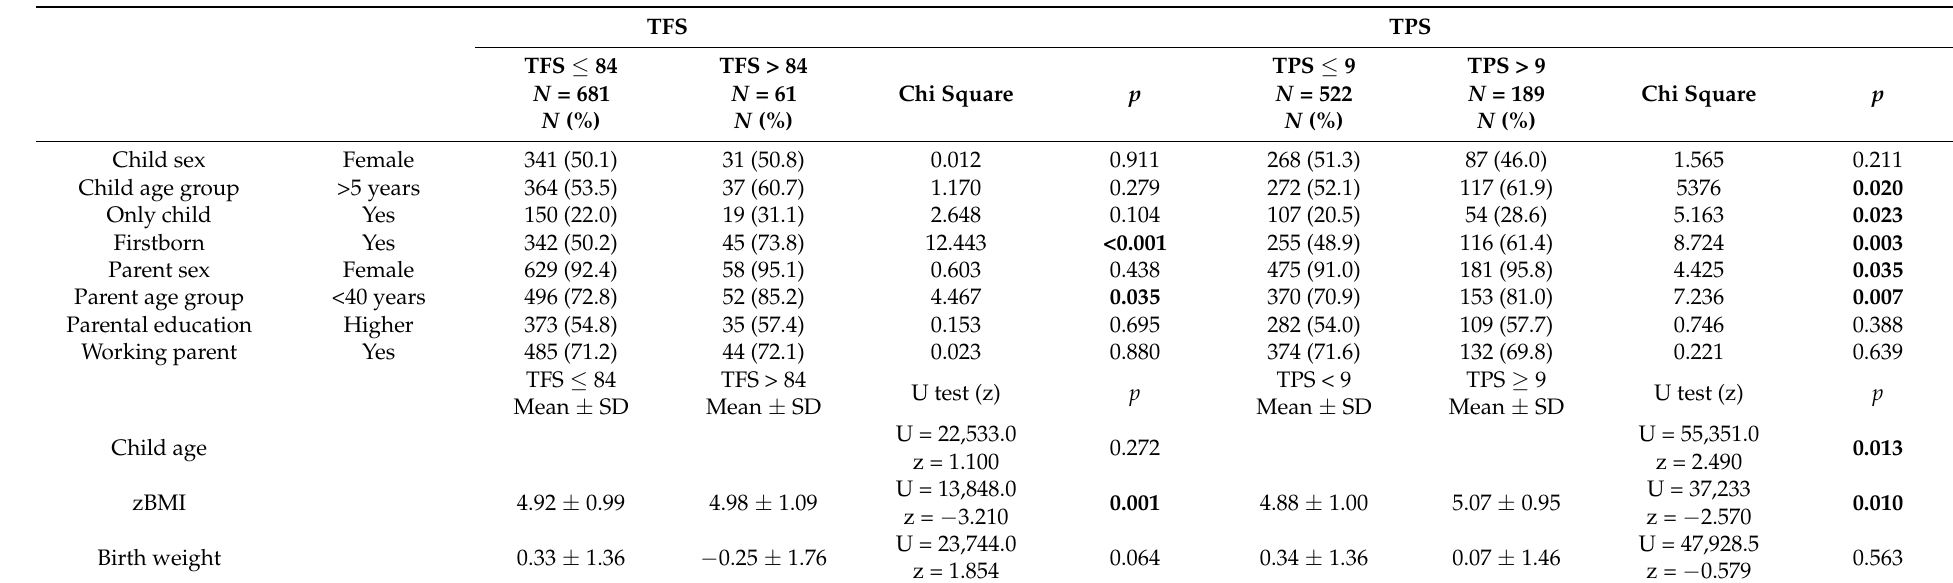
Table 4. Comparison of children with high vs. low TFS/TPS score in relation to